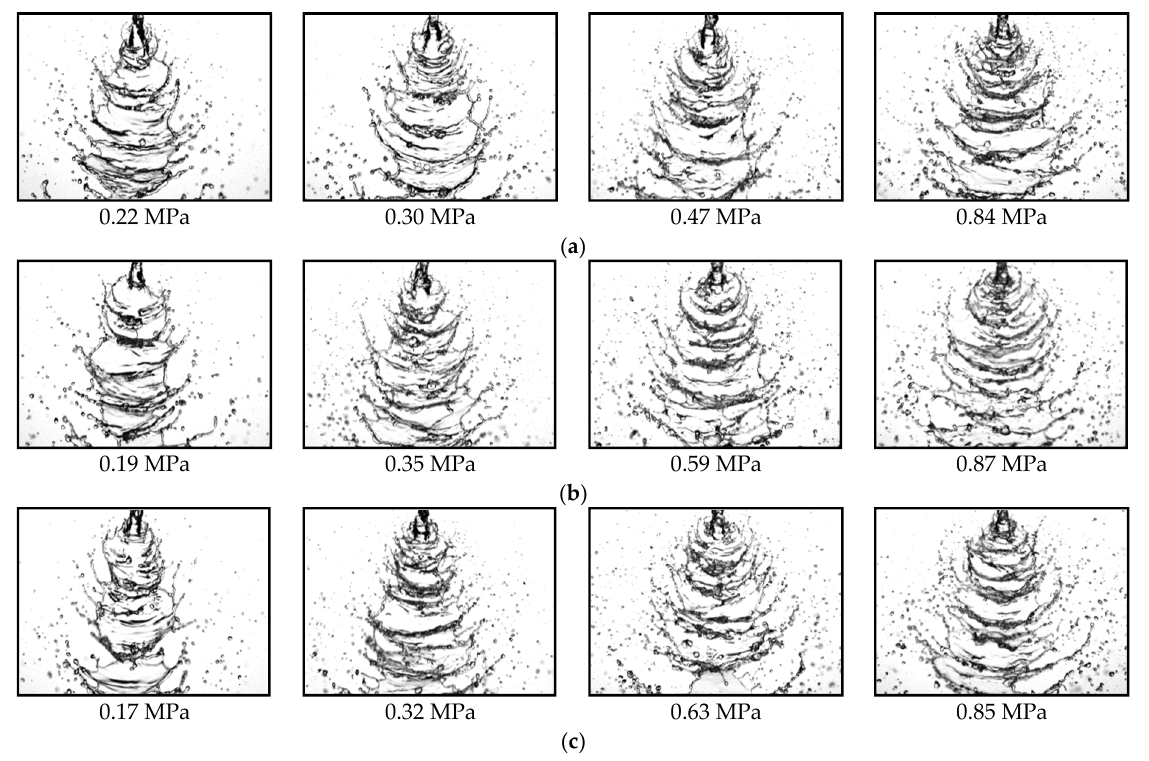
Figure 10. The atomization field structure images of N 1 , N 6 and N 11 nozzles under different input pressures at 60° collision angle. ( a ) N 1 . ( b ) N 6 . ( c ) N 11 .